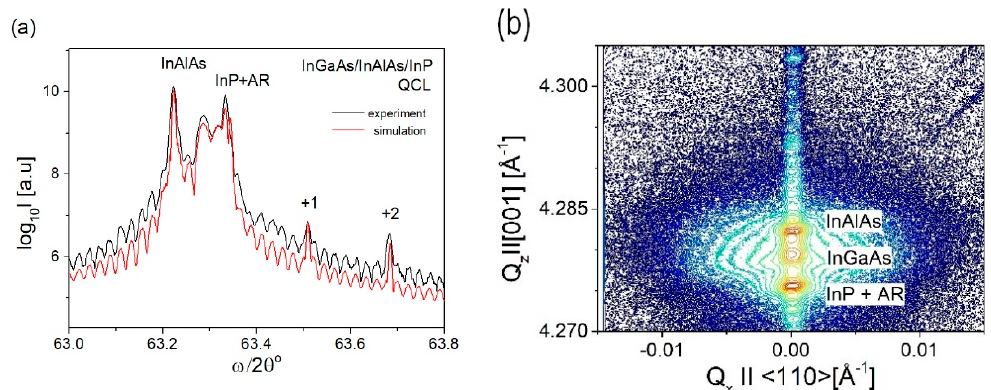
Figure 2. ( a ) ω / 2 θ scan of QCL sample; ( b ) reciprocal space map of X-ray intensity around 004 Bragg reflection for In 0.53 Ga 0.47 As / In 0.52 Al 0.48 As / InP QCL. Di ff use X-ray scattering is seen as isointensity contours growing in horizontal direction, i.e., perpendicular to [004] Bragg di ff raction vector which is displayed in a vertical direction on the map. Subsequent contours of X-ray intensity are shown in a logarithmic scale and separated by a factor of